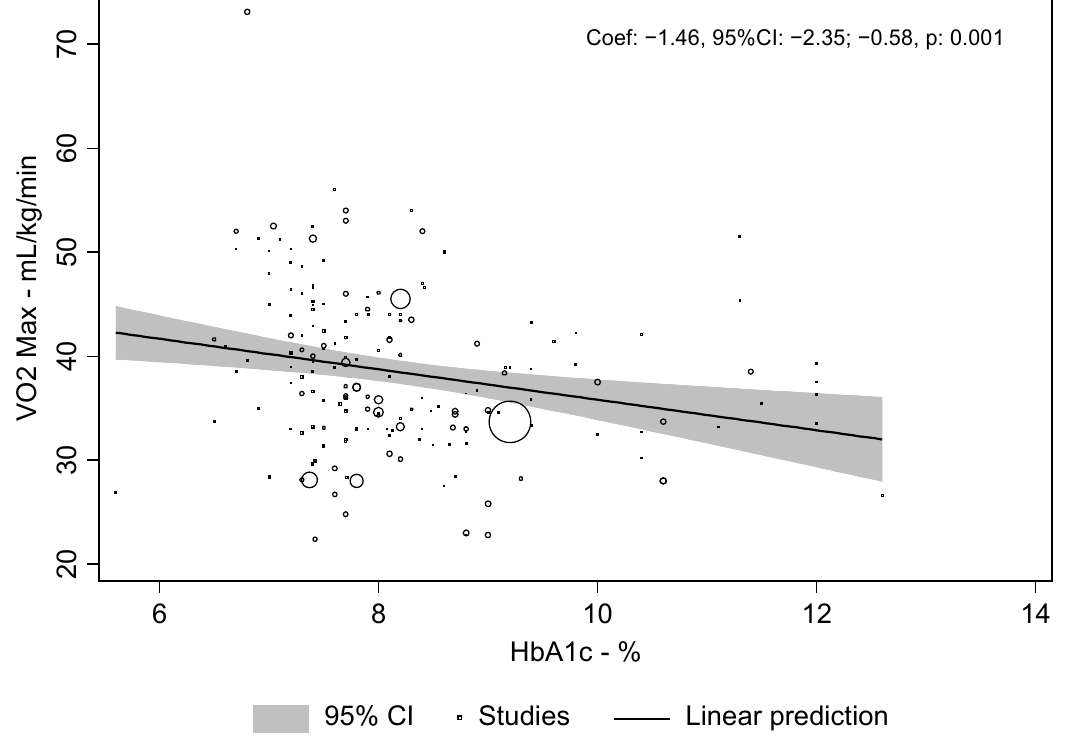
Figure 3. Meta-regression dot plot for HbA 1c and VO 2max Figure 3. Meta ‐ regression dot plot for HbA 1c and VO 2max .